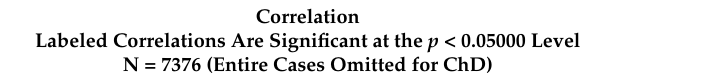
Table 7. Correlation coefficient—s for Co-0% gluten-free dough leavening corresponding to Figure 10. Calculated in STATISTICA CZ version 12 (StatSoft, Inc.,